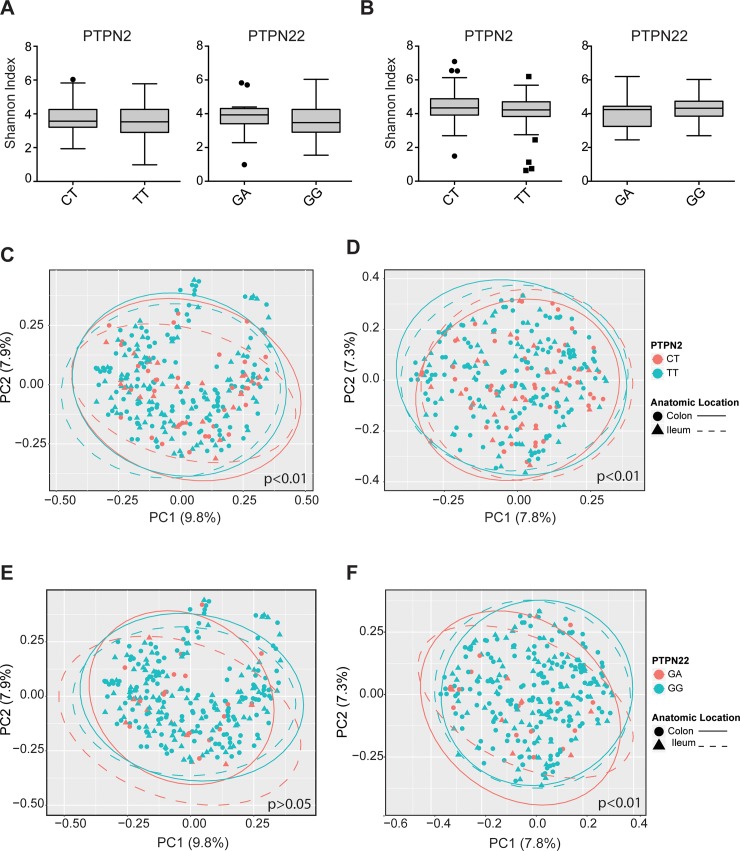
The microbial features associated with disease phenotype and IBD-associated risk variant rs1893217 and rs2476601.Species richness is calculated using Shannon index in CD (A) and UC (B) samples. Beta diversity is calculated for CD (C) and UC (D) samples in the context of PTPN2 variant and for CD (E) and UC (F) samples in the context of PTPN22 variant using Bray-Curtis dissimilarity matrix. Heterozygous variants are red color while homozygous wild-type ones are turquoise. Colon samples are labeled as closed circle and ileum samples are labeled as closed triangles. Ellipses represent dispersion of samples and ellipses for colon samples are labeled with straight line while ellipses for ileum samples are labeled are label dashed line. A p-value <0.05 is considered significant. Significant differences are marked through the panels.